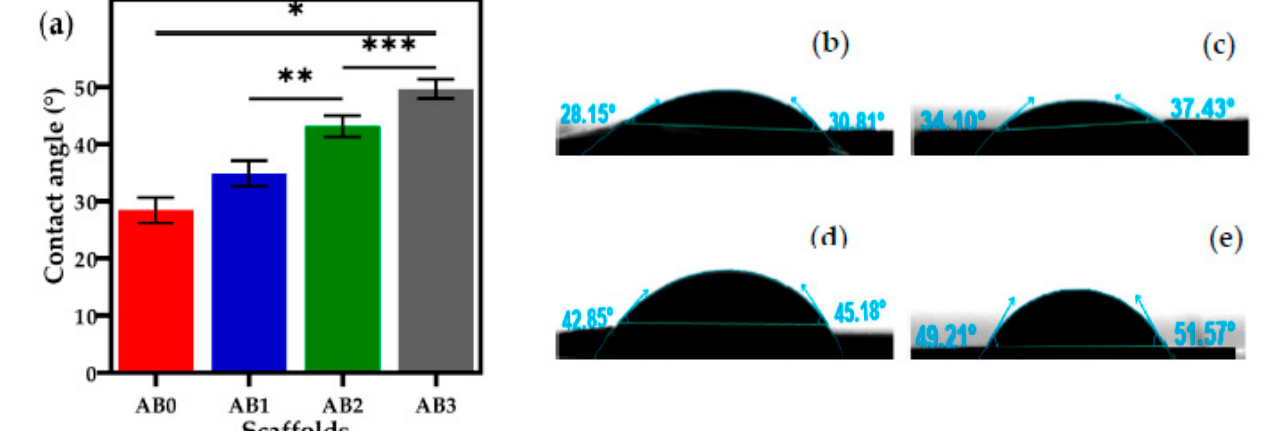
Figure 8. ( a ) Contact angle measurements of scaffolds (* p < 0.05, ** p < 0.01, *** p < 0.001; n = 3); sessile drop images ( b ) AB0; ( c ) AB1; ( d ) AB2; and ( e ) AB3.